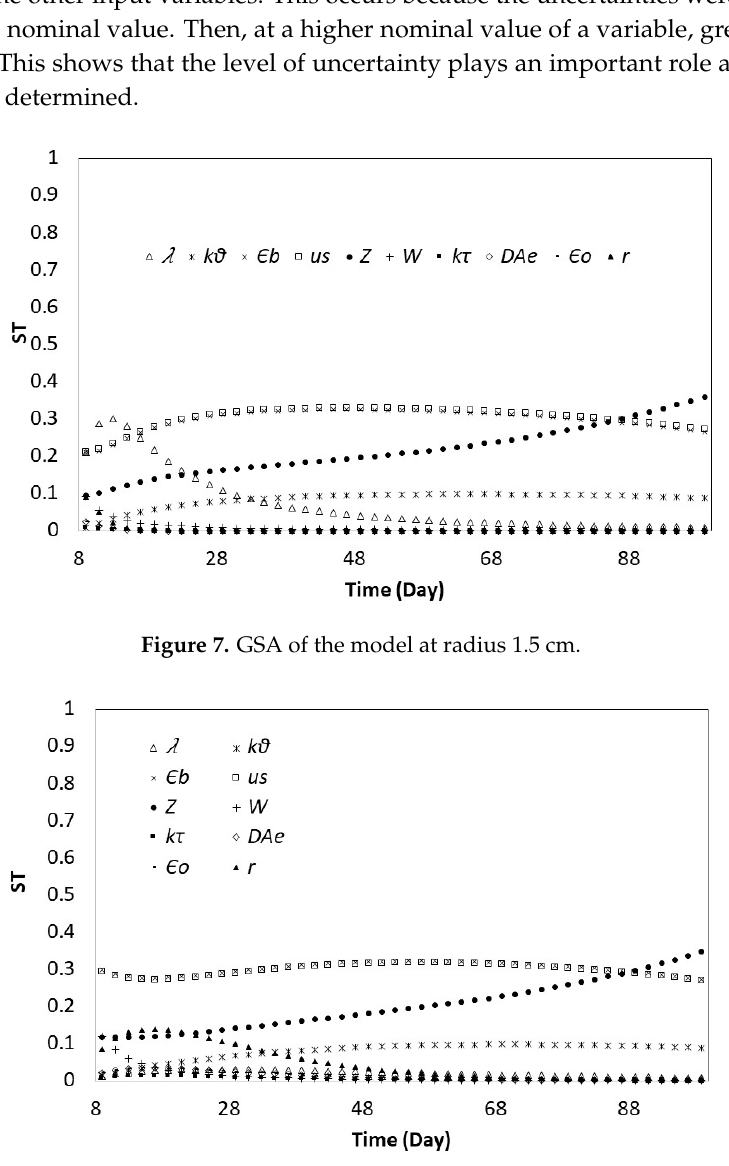
Figure 9. GSA of the model at (cid:1873) (cid:3046) 9.0 cm 3 /cm 2 ·s.